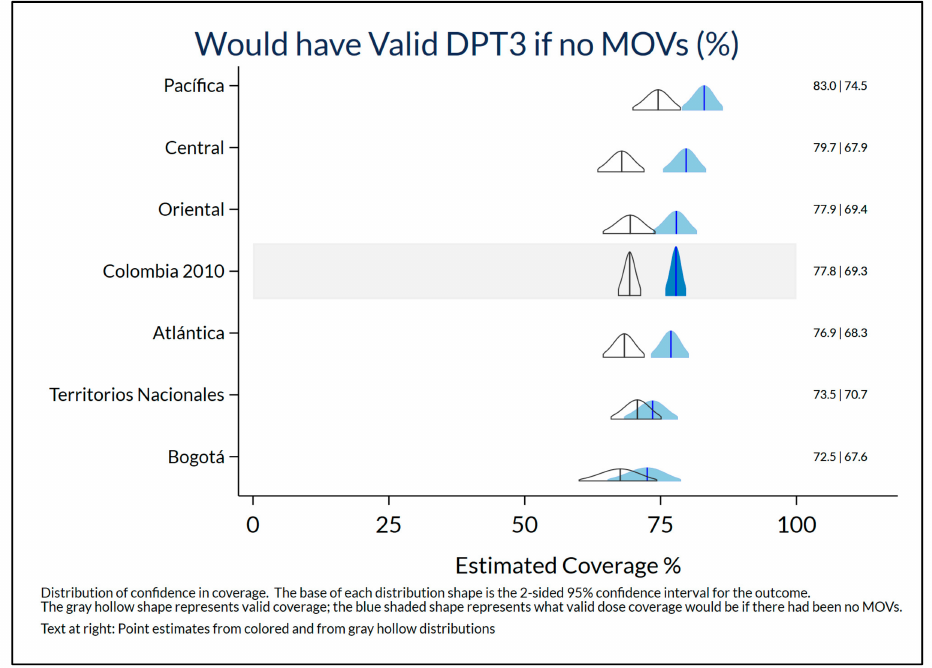
Figure 5. Observed valid coverage of DPT3 and potential valid coverage achievable if every dose due had been administered at every vaccination visit, among children aged 12–23 months with HBRs, Colombia DHS